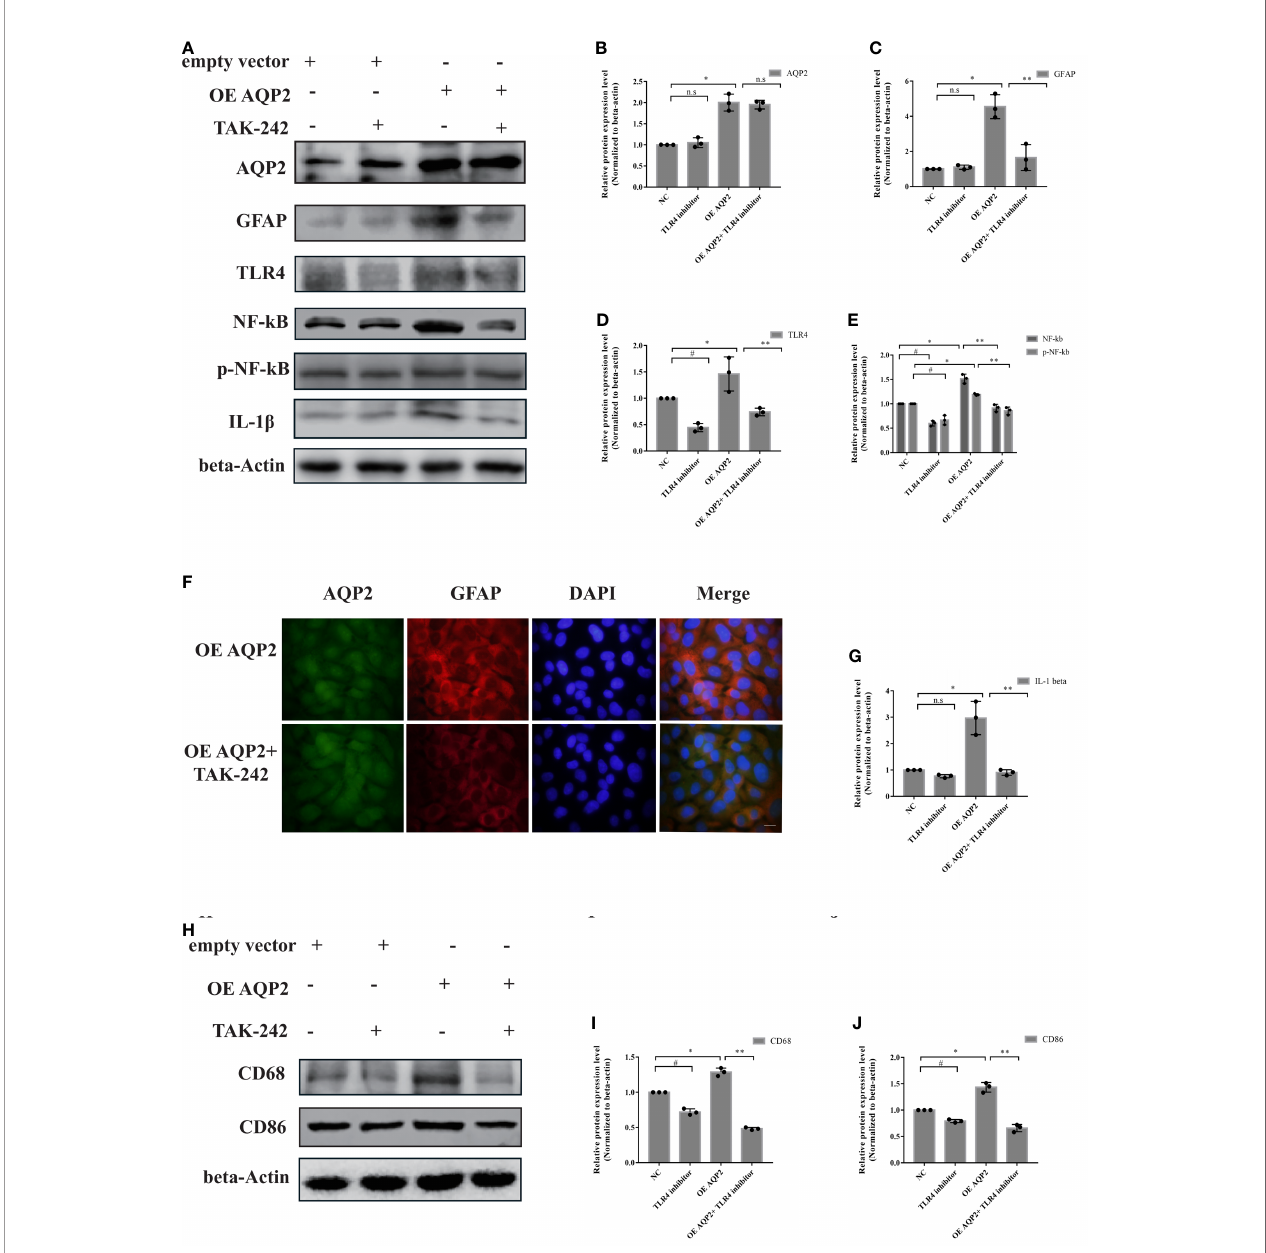
FIGURE 6 | AQP2 overexpression-induced pro-in fl ammation secretion is partially caused by TLR4 signaling activation in astrocyte. Astrocyte with overexpressed AQP2 (pcDNA3.1-AQP2 plasmid) were exposed to TLR inhibitor (TAK-242) for 24 h. (A) Western blot analysis of AQP2, GFAP, TLR4, NF- k B, phospho- NF- k B and IL-1 b in astrocyte transfected with pcDNA3.1 empty vector or pcDNA3.1-AQP2 plasmid treated with or without TAK-242 (n = 3/group). (B – E, G) Quanti fi cation of the relative protein expression levels of AQP2, GFAP, TLR4, NF-kB and IL-1 b . ( # p < 0.05, empty vector + vehicle vs. empty vector+ TAK-242; *p < 0.05, empty vector + vehicle vs. pcDNA3.1-AQP2 plasmid + vehicle; **p < 0.05, pcDNA3.1-AQP2 plasmid + vehicle vs. pcDNA3.1-AQP2 plasmid + TAK-242). The data are presented as the mean ± s.d. of three independent experiments. (F) Immuno fl uorescence of AQP2 (red signal) and GFAP (green signal) in astrocyte with AQP2 overexpression treated with or without TAK-242. Astrocyte cell nuclei were immunostained (blue, DAPI). Scale bar: 10 m m. (H) Microglia were treated with medium of astrocyte for 24h transfected with pcDNA3.1 empty vector or pcDNA3.1-AQP2 plasmid (with or without TAK-242). CD68 and CD86 were assessed by western blotting (n = 3/group). Quanti fi cation of the relative protein expression level of CD68 (I) and CD86 (J) is shown. ( # p < 0.05, empty vector + vehicle vs. empty vector+ TAK-242; * p < 0.05, empty vector + vehicle vs. pcDNA3.1-AQP2 plasmid + vehicle; **p < 0.05, pcDNA3.1-AQP2 plasmid + vehicle vs. pcDNA3.1-AQP2 plasmid + TAK-242). The data are presented as the mean ± s.d. of three independent